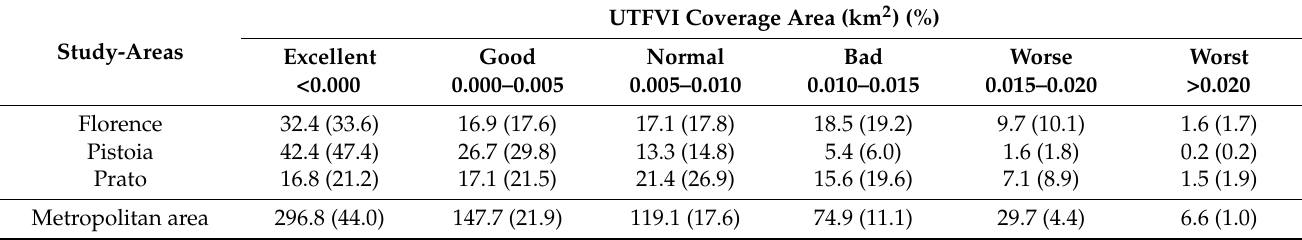
Table 2. Percentage coverage area by Urban Thermal Field Variance Index (UTFVI) classes for the overall metropolitan area and the three largest